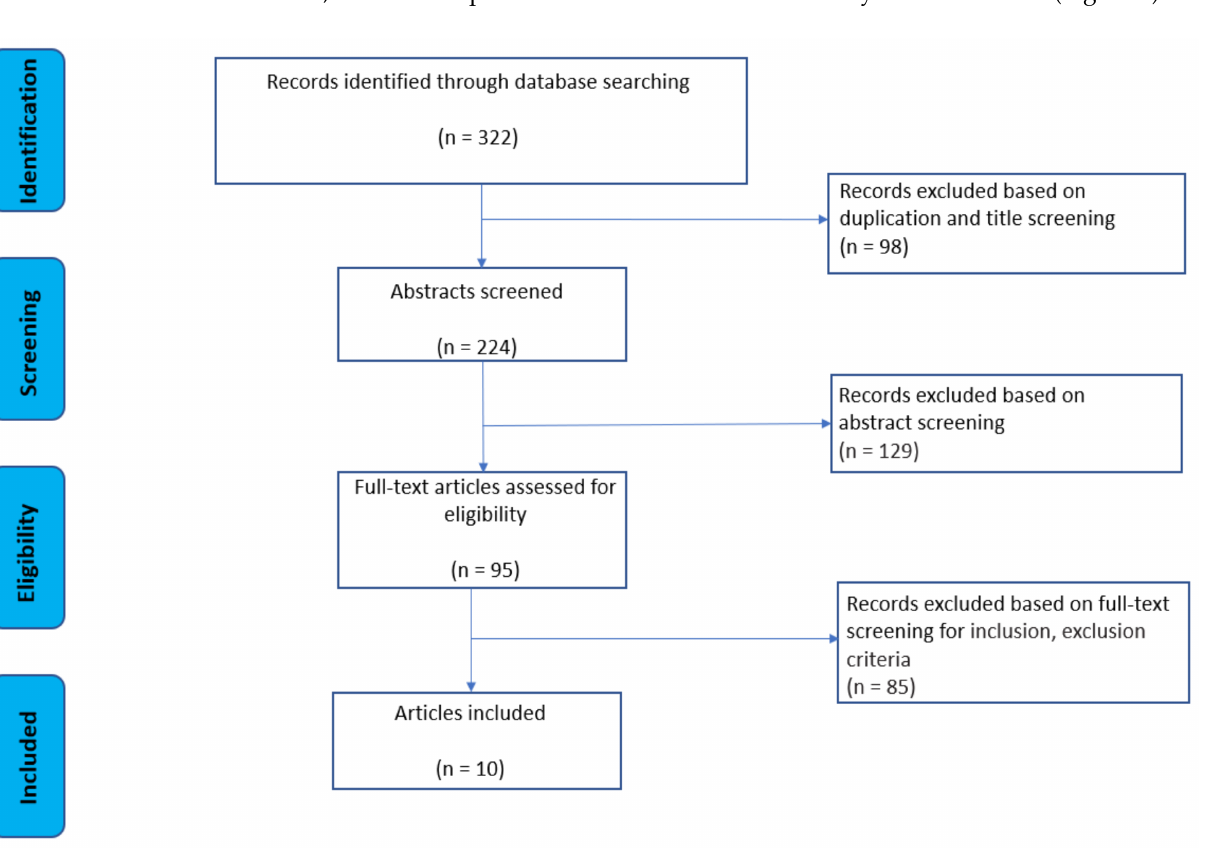
Figure 1. Strategy of literature review